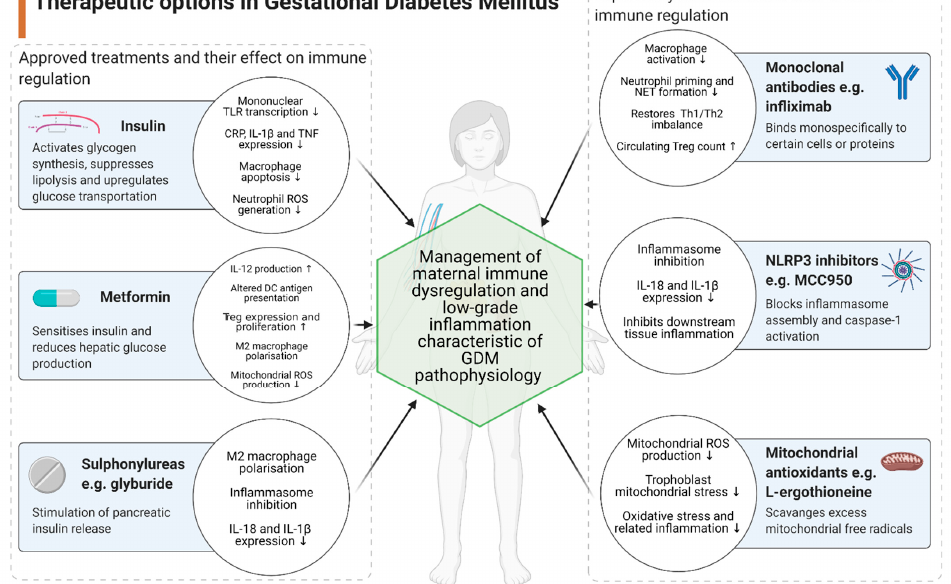
Figure 2. Immune-mediated effects of both clinically approved and potential therapeutic options for GDM. Created with Biorender.com. ↑ , increased; ↓ , decreased; TLR, Toll-like receptor; CRP, c-reactive protein; IL, interleukin; TNF, tumour necrosis factor; ROS, reactive oxygen species; DC, dendritic cell; Th1, T-helper 1 cell; Th2, T-helper 2 cell; Treg, regulatory T cell; NET, neutrophil extracellular trap; NLRP3, NOD-, LRR- and pyrin domain-containing protein 3.